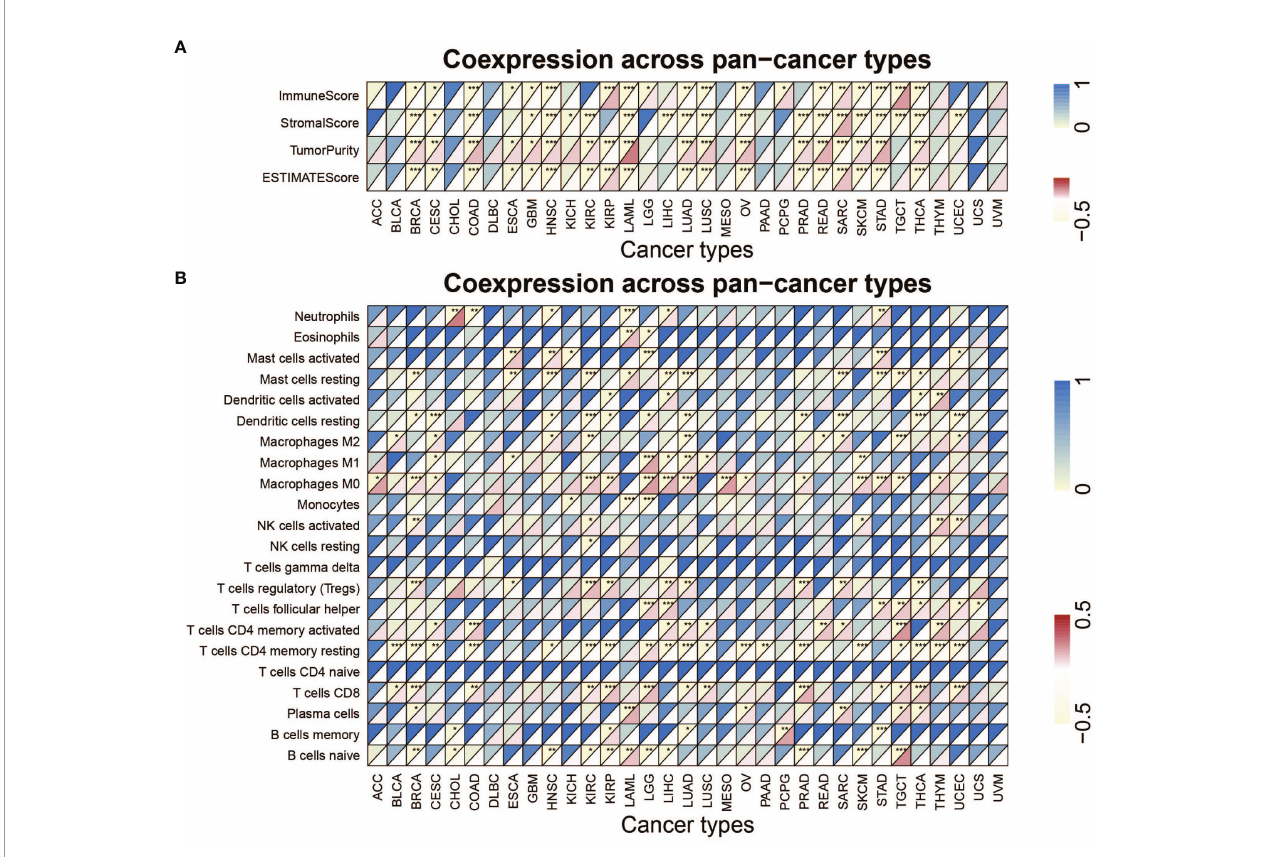
FIGURE 6 | Analysis of METTL1 expression related immune characteristics. (A) Heatmap visualized the relationship between METTL1 expression and immune score, stromal score, tumor purity as well as ESTIMATE score in pan-cancer. (B) Heatmap showed correlation between METTL1 expression and 22 immune cell in fi ltration value obtained by CIBERSORT algorithm among pan-cancer. Upper half of each grid exhibited the p value and lower half exhibited the correlation coef fi cient. * means P < 0.05; ** means P < 0.01; *** means P <